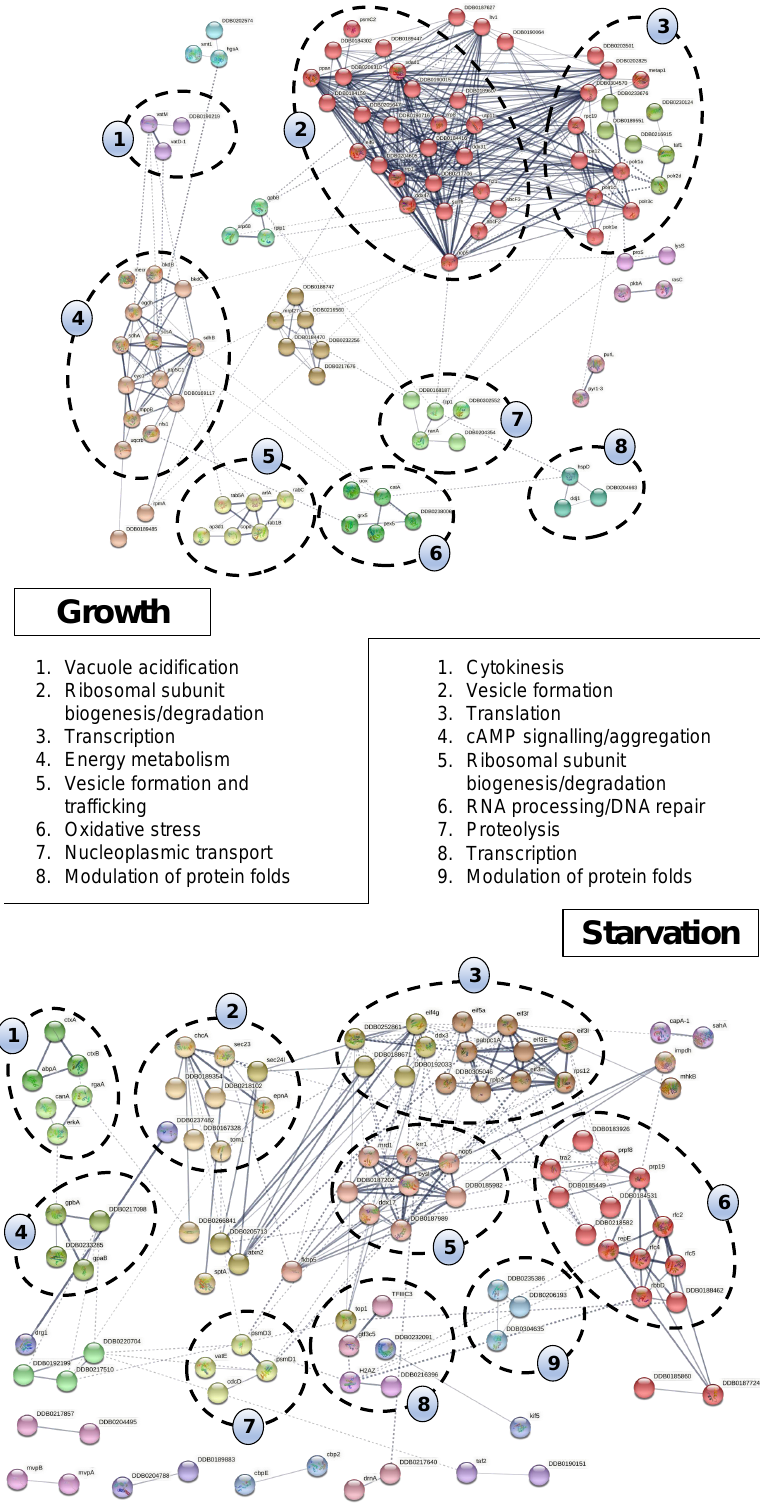
Figure 3. Search Tool for the Retrieval of Interacting proteins (STRING) analysis of putative calmod- ulin (CaM) interactors unique to growth and starvation. The lines between protein nodes represent interactions under a threshold of medium interacting confidence score (0.400). The edges represent the predicted functional associations. Clustering was performed with an MCL inflation parameter value of 2 with some protein nodes moved to other clusters due to the protein description matching the identified pathway. Clustered proteins are shown in numbered